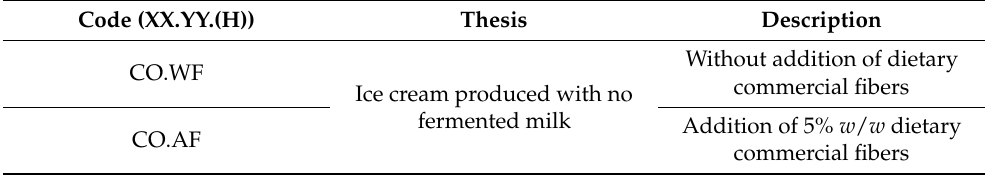
Table 1. Cont. Code